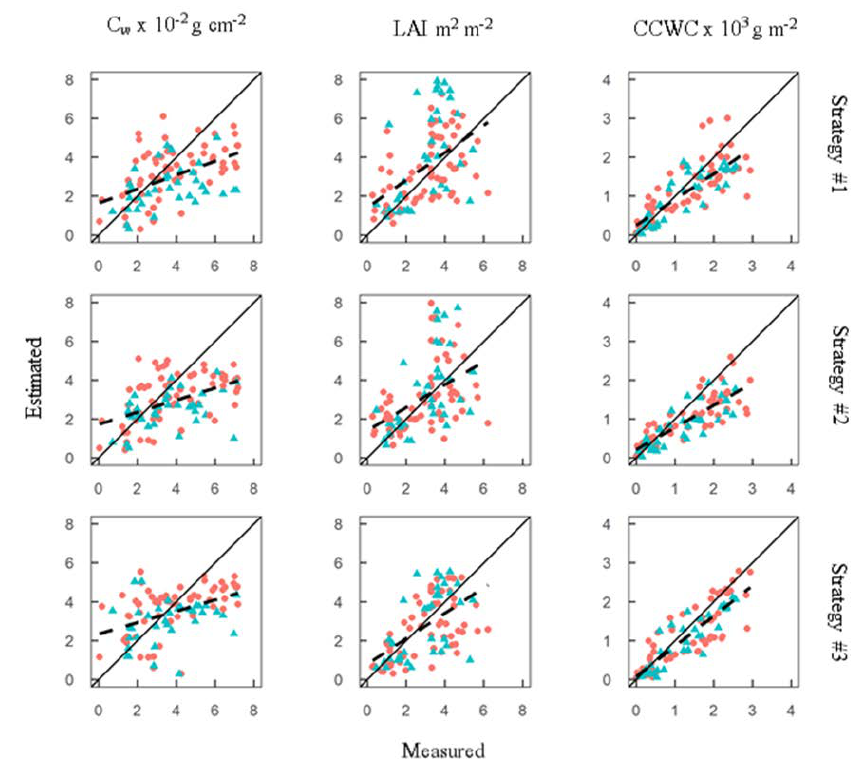
Figure 12. Scatter plots of measured and estimated C w , LAI , and CCWC (Left, middle, and right, respectively), presented for strategies 1, 2, and 3 (top, middle, and bottom, respectively). The regression lines are plotted as a dashed line, the solid 1:1 line is shown for reference. The red dots and green triangles correspond to Landsat-8 and Sentinel-2 HLS derived observations, respectively. Table 8. Regression and validation metrics for LAI , C w , and CCWC estimated through the three inversion strategies. The table presents the results obtained considering Landsat-8 (L8) data only, Sentinel-2A (S2) data only, and both sensors (L8/S2).